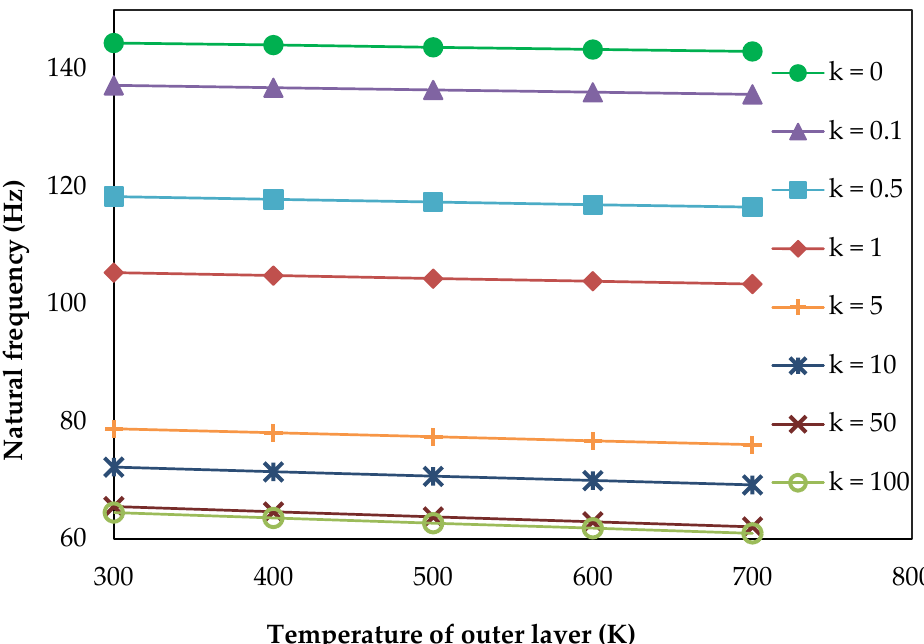
Figure 13. Variation of the natural frequency of a Ti-6Al-4V/silicon carbide FGM shell under a linear temperature rise for different material composition for re-entry vehicle nose structures.